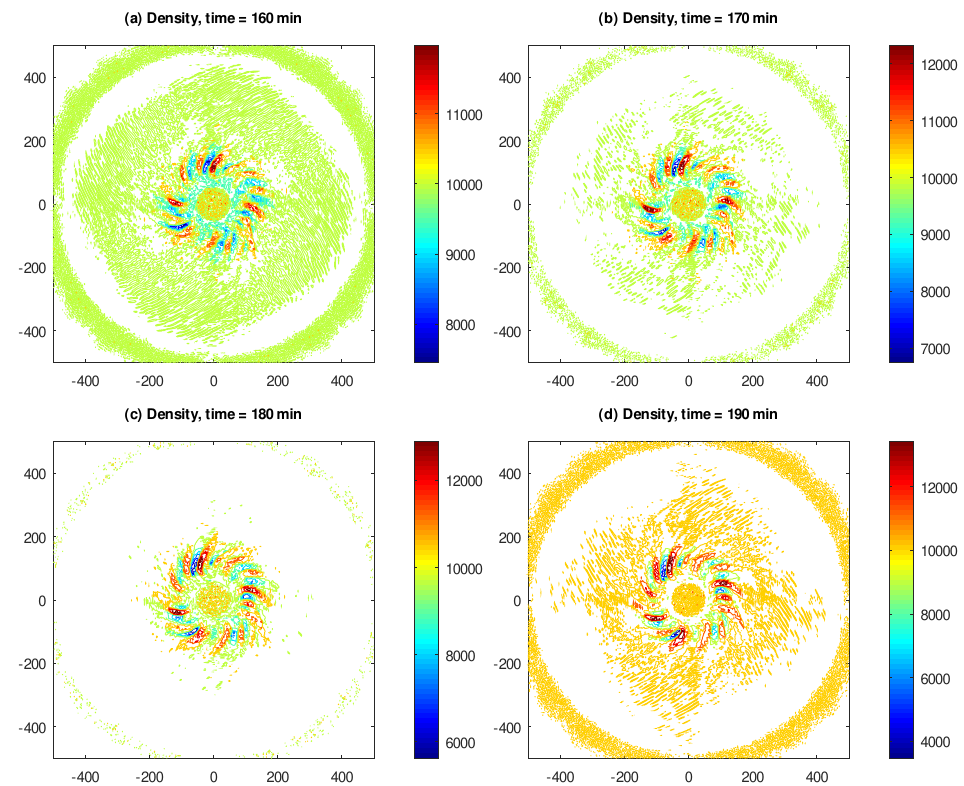
Figure 9. Density of the cyclostrophic flow, expressed in kg/m 2 , and captured at ( a ) 160, ( b ) 170, ( c ) 180 and ( d ) 190 min of elapsed model time. The domain size is 1000 × 1000